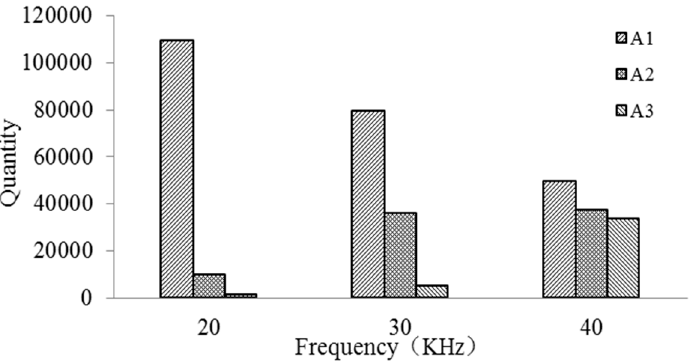
Figure 16. The quantity of debris distribution.